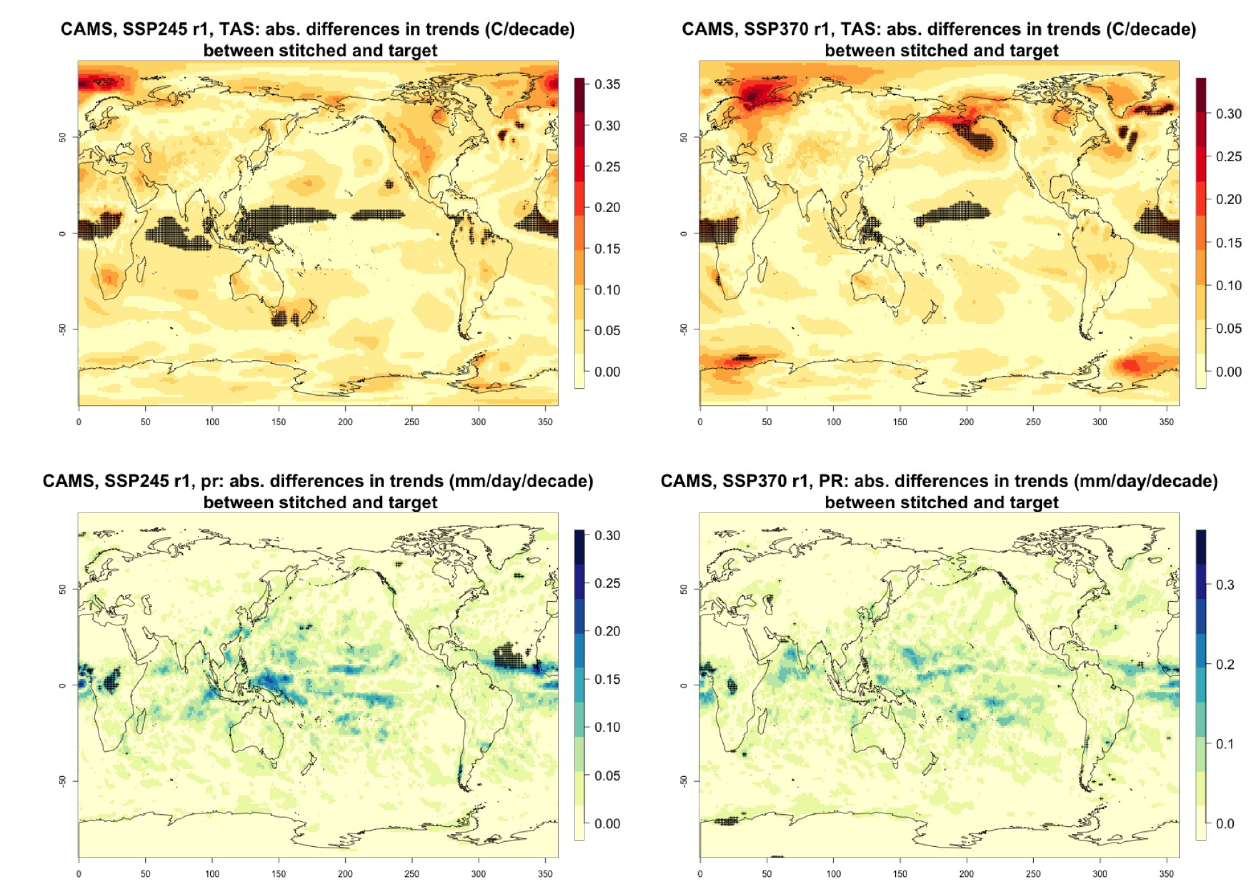
Figure 3. Absolute difference in future trends of monthly temperature variability (TAS) and precipitation (PR) between stitched and target realizations. The value of the difference is expressed by the color scale, and we marked with black crosses those locations where the trends computed from target and stitched time series do not overlap in their 95% confidence intervals, indicating statistically significant differences. Emulation of CAMS-CM1-0 monthly time series for 2015–2100 under SSP2-4.5 and